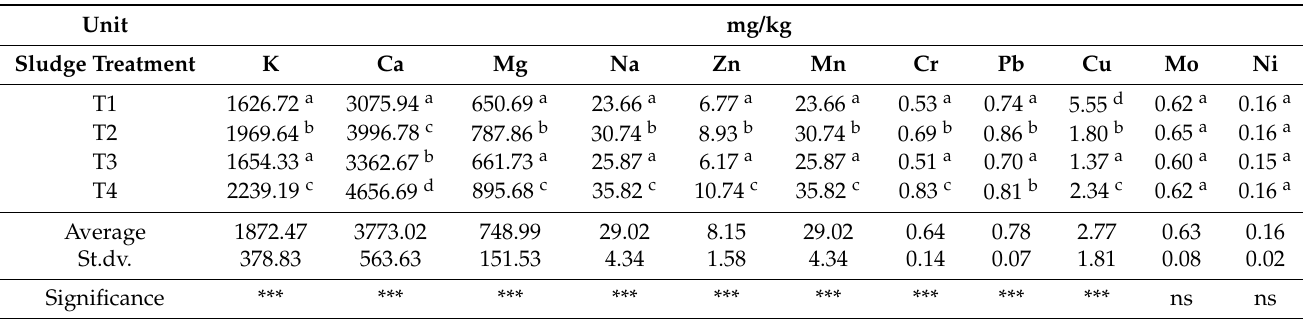
Table 8. Macro-and microelement content of Virginia mallow biomass after application of different amounts of sewage